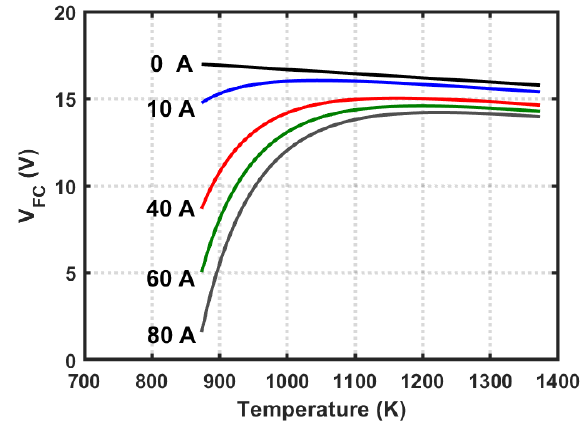
Figure 11. FC stack voltages vary with the stack temperature and output current.